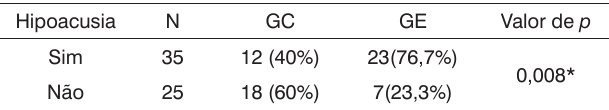
Tabela 2. Probabilidade de hipoacusia em alguma frequência e em alguma